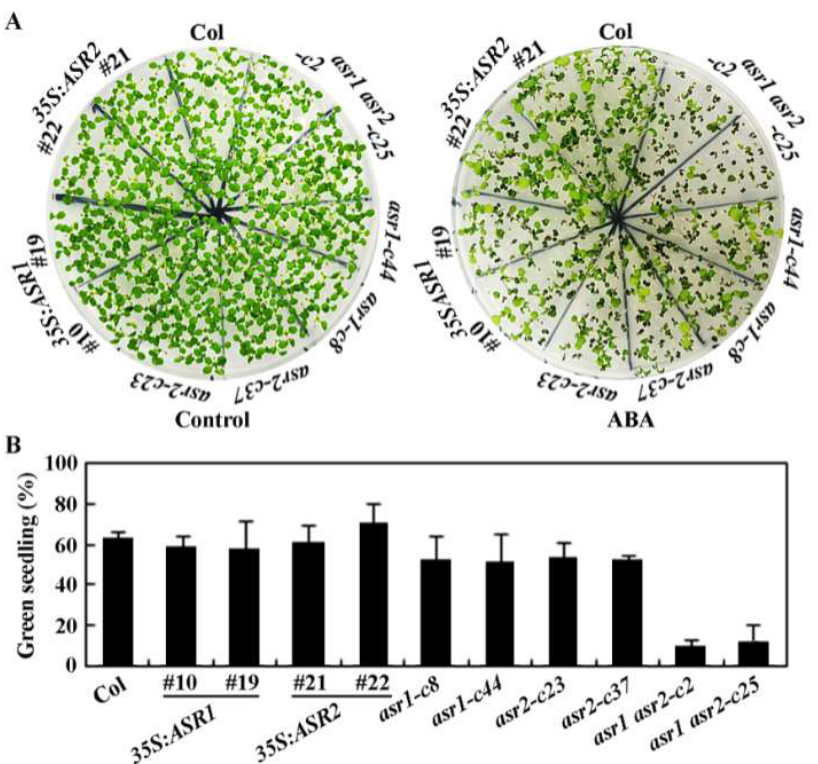
Figure 5. Effects of ABA on cotyledon greening of the Col wild type, the 35S : ASR1 and 35S : ASR2 transgenic plants, the asr1 and asr2 single and the asr1 asr2 double mutants. ( A ) Cotyledon greening of the Col wild type, the 35S : ASR1 and 35S : ASR2 transgenic plants, the asr1 and asr2 single and the asr1 asr2 double mutants in response to ABA treatment. Sterilized seeds were sown on 1/2 MS plates with or without 0.5 μM ABA. The plates were kept at 4 °C in dark for 2 days and then transferred to growth room. The numbers of seedling with green cotyledons were counted and pictures were taken 12 days after the transfer. ( B ) Percentage of green seedlings of the Col wild type, the 35S : ASR1 and 35S : ASR2 transgenic plants, the asr1 and asr2 single and the asr1 asr2 double mutants in response to ABA treatment. Numbers of seedlings with green cotyledons were counted and percentage of green seedlings was calculated. Data represent the mean ± SD of three replicates.